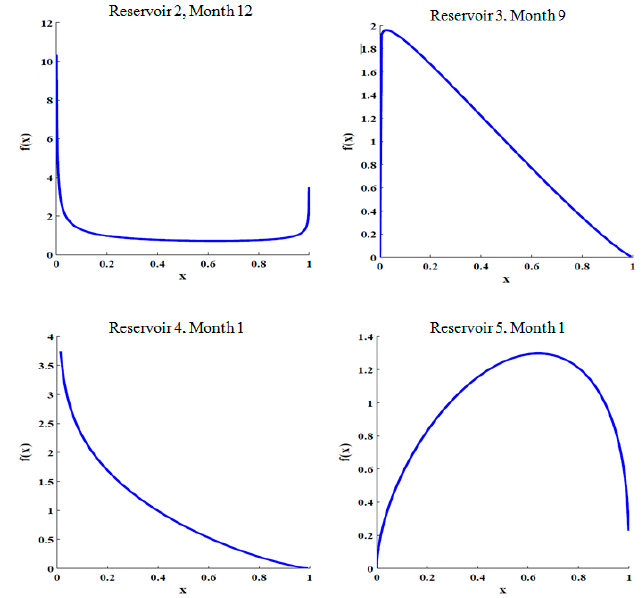
Figure 5. Examples for the probability density functions of inflows to reservoirs [19].